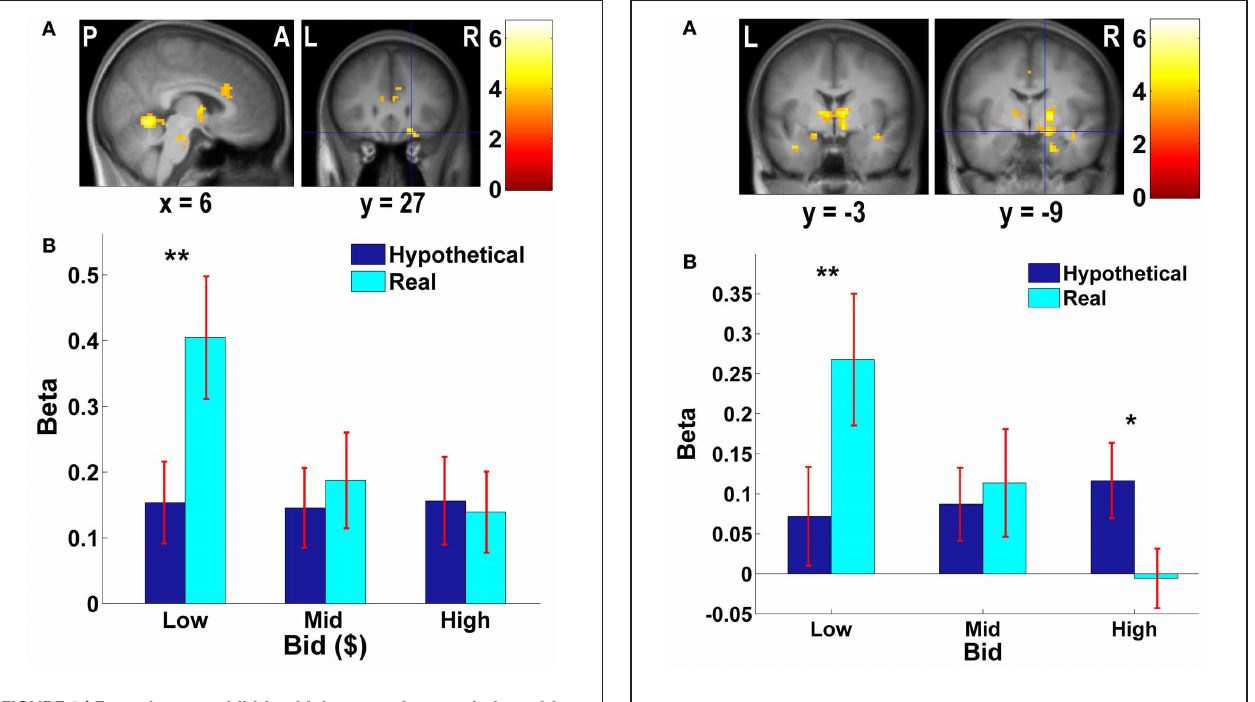
FIGURE 4 | Subcortical areas exhibiting higher negative correlation with real bids than hypothetical bids. (A) Deactivations in the [real × bid - hypothetical × bid] contrast ( p < 0 . 001, uncorrected; threshold k ≥ 5 voxels). The color bar on the right indicates the t -score. (B) Average response in the amygdala area to different levels of bids by trial type. Due to continuous activations in surrounding areas, the amygdala mask was defined as an intersection of the two following regions: (1) a right amygdala area (local peak at x = 15 , y = − 9 , z = − 12) identified in the [real × bid - hypothetical × bid] contrast [the area with crosshairs shown in the right panel of (A) ]; and (2) a 8-mm sphere centered at the local peak of the area in (1) at x = 15 , y = − 9 , z = − 12. β values extracted from this amygdala mask. ∗∗ p = 0 . 015, ∗ p = 0 . 034, no asterisk = not significant, paired two-sample t